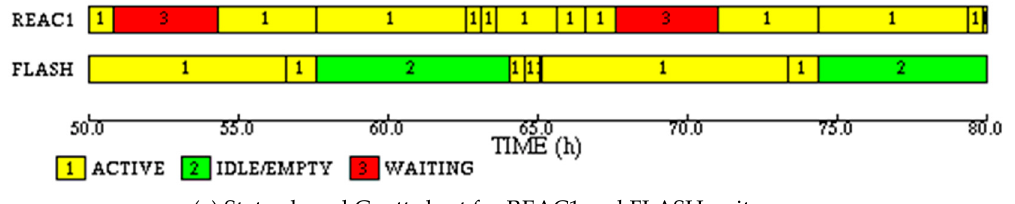
Figure 14. Subtask and status based Gantt charts for REAC1 and FLASH for base case.